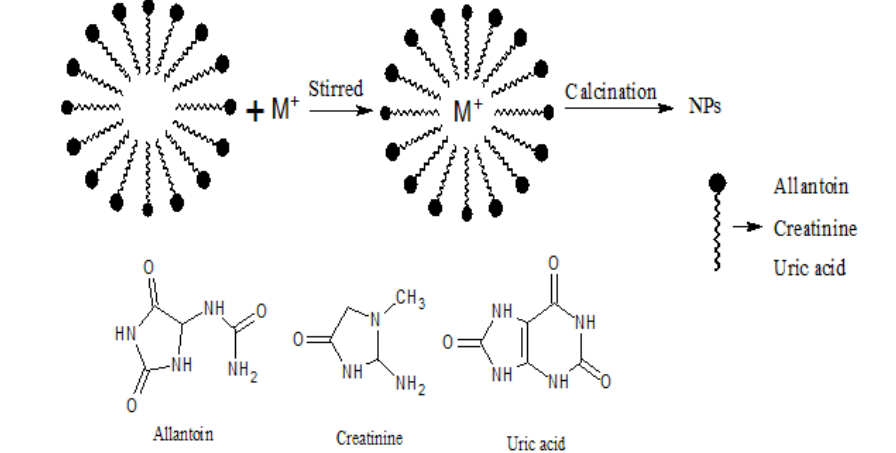
Fig. 5. Plausible mechanism of green synthesis of NPs using cow